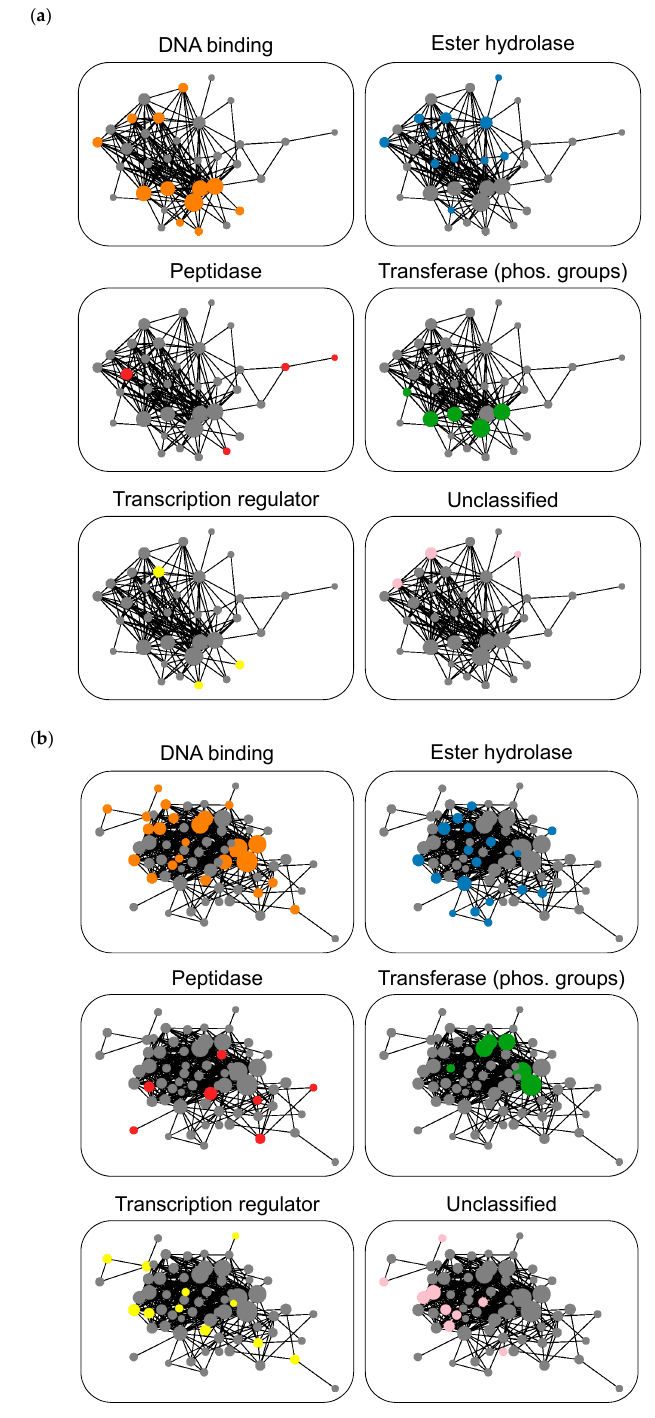
Figure 4. Target networks for multi-target compounds. In ( a , b ), networks are shown for MT-CPDs from biochemical and mixed assays, respectively. Each node represents an individual target that is scaled in size according to the number of its MT-CPDs. Nodes are connected by edges if the corresponding targets share at least 50 MT-CPDs. Since a target may have multiple functional annotations, all panels display the same target network colored according to the absence (gray) or presence of a given protein function (orange, DNA binding; blue, ester hydrolase; red, peptidase; green, phosphorous group transferase; yellow, transcription regulator; pink,